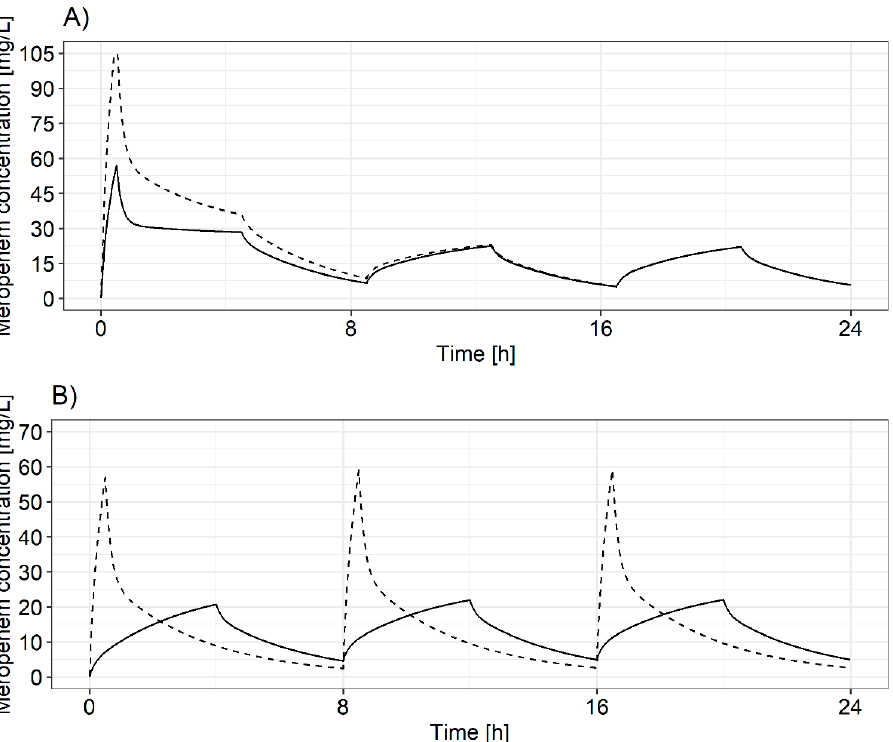
Figure 2. Predicted meropenem concentration–time profiles based on deterministic simulations using the reduced population pharmacokinetic model for a patient with creatinine clearance of 80.8 mL/min. ( A ) After either a 1000 (solid line) or a 2000 mg (dashed line) loading dose followed by prolonged (4 h) 1000 mg meropenem infusions with a dosing interval of 8 h. ( B ) After either a short-term (0.5 h; dashed line) or a prolonged (4 h; solid line) 1000 mg meropenem infusion administered every 8 h. Table 3. Probability of target attainment for different dosing regimens administered to a patient with a creatinine clearance according to Cockroft–Gault of 120 mL/min and infected by a pathogen with a minimum inhibitory concentration of 4 mg/L for meropenem.